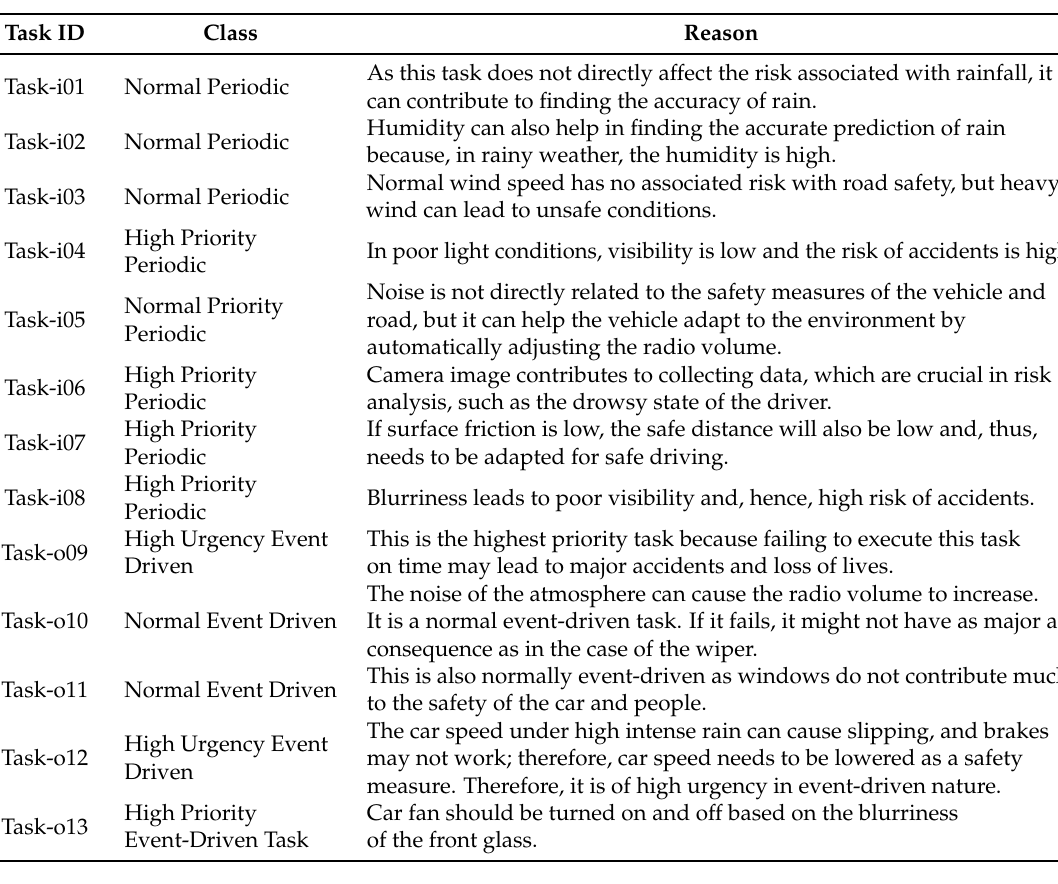
Table 5. Categorization of different tasks based on severity of